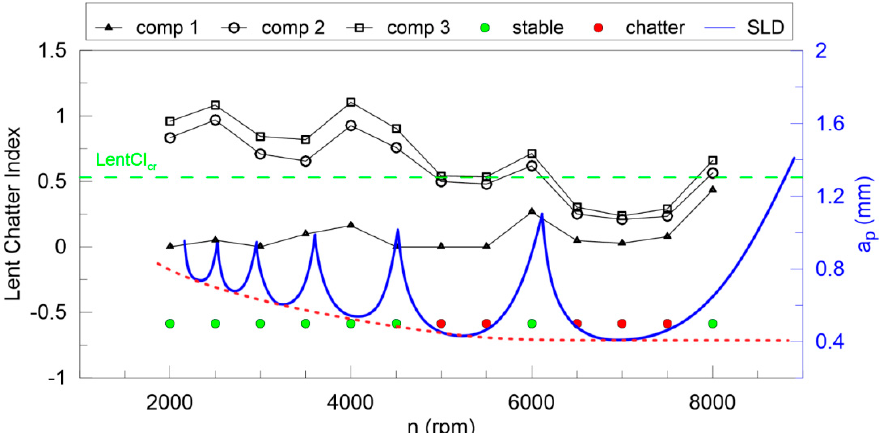
Figure 15. The L ent chatter index (left axis) and the hypothetical stability lobe diagram (right axis) versus cutting velocity.